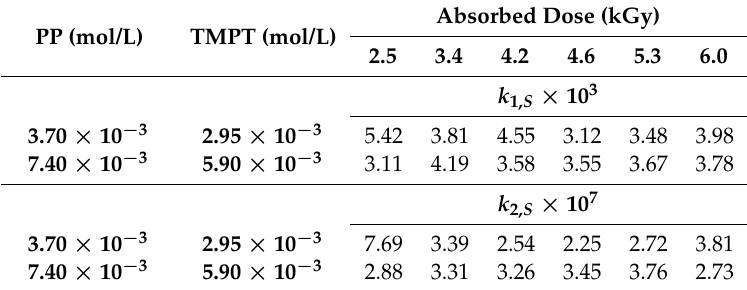
Figure 6. The second-order swelling kinetics for hydrogels obtained at: ( a ) 2.5 kGy, 3.4 kGy and 4.2 kGy; ( b ) 4.6 kGy, 5.3 kGy and 6.0 kGy. ( b ) 4.6 kGy, 5.3 kGy and 6.0 kGy. Table 3. The variation of first-order, k 1, S /min −1 and second-order k 2, S /g gel · (g water · min) −1 swelling rate Table 3. The variation of first-order, k 1, S /min − 1 and second-order k 2, S /g gel · (g water · min) − 1 swelling constants with the amount of TMPT, PP and absorbed dose. rate constants with the amount of TMPT, PP and absorbed dose.